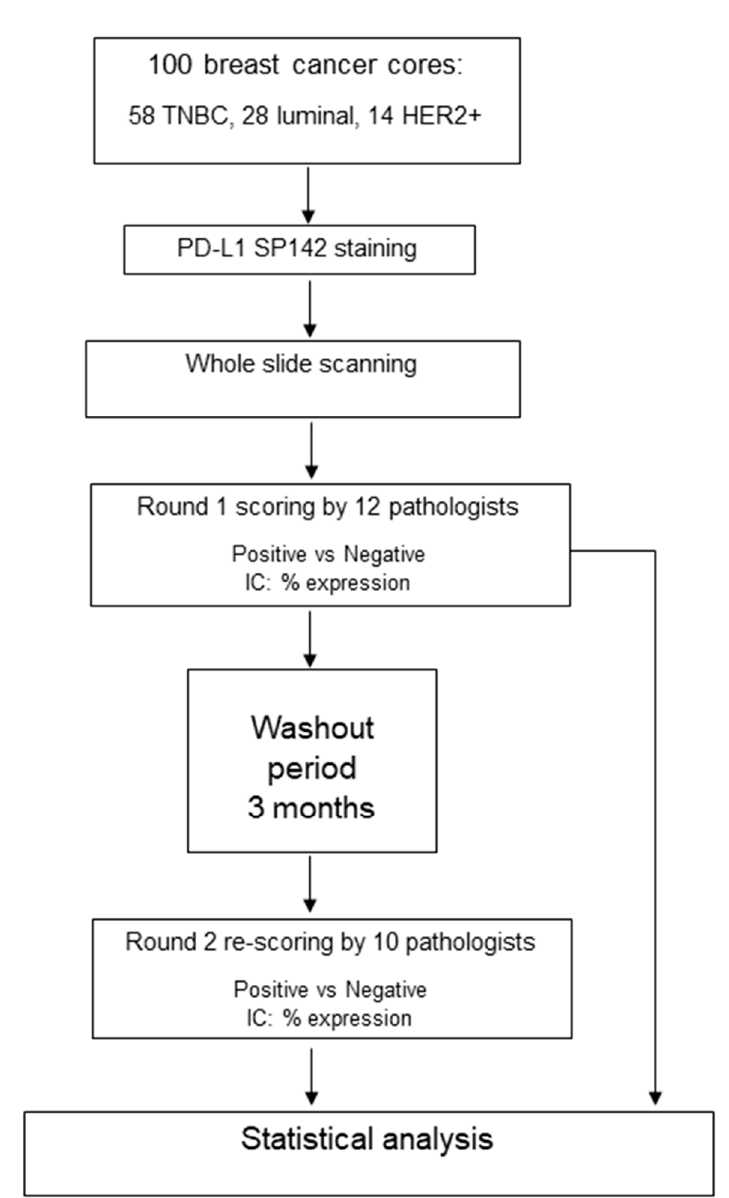
Figure 1. A flowchart showing the outline of the